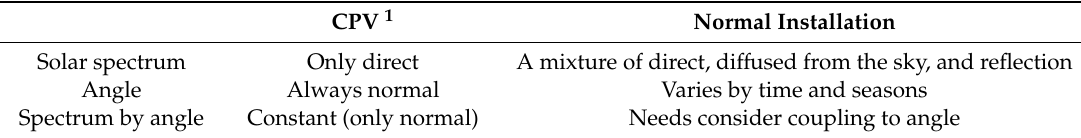
Table 1. The difference in performance modeling between concentrator photovoltaic (CPV) and standard installation [1]. The outdoor performance of CPV was intensively studied in more than 20 years considering the spectrum mismatching problem of the tandem solar cells. CPV 1 Normal Installation Solar spectrum Only direct A mixture of direct, di ff used from the sky, and reflection Angle Always normal Varies by time and seasons Spectrum by angle Constant (only normal) Needs consider coupling to